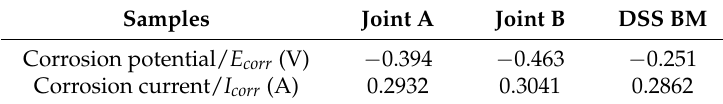
Table 3. Electrochemical parameters of DSS BM and weld metals [103]. DSS: duplex stainless steel. BM: Base Metal.